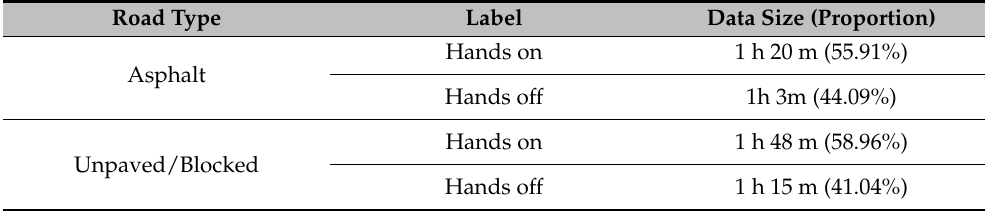
Figure 3. Data collection roads. ( a ) An asphalt road with a bump (red rectangle); ( b ) an asphalt road; ( c ) an unpaved road; ( d ) a sidewalk blocked road. Table 1. Summary of collected data. Total data are about 5 h and 35 min, and were well balanced.